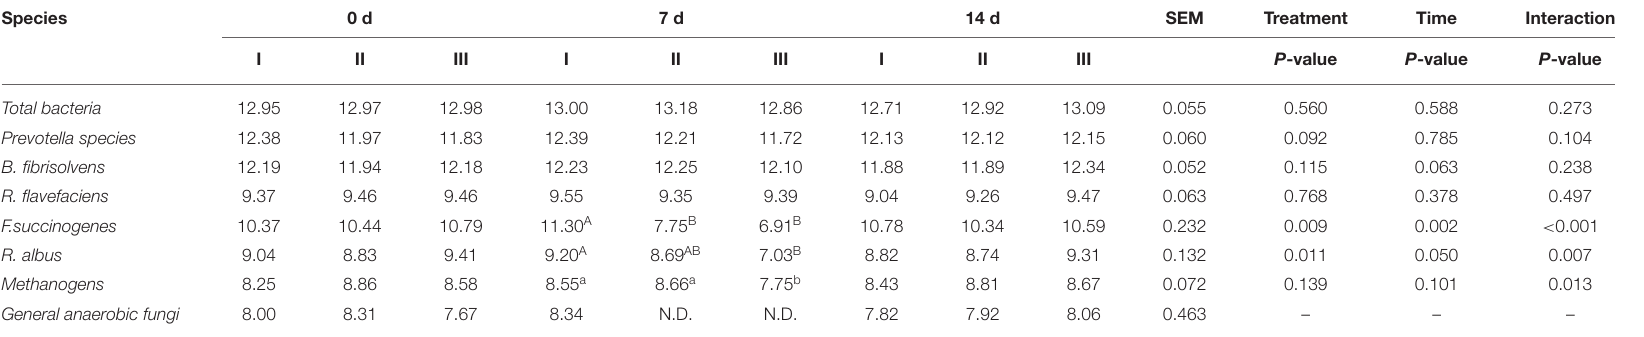
TABLE 3 | Log copies of a target microorganism in rumen fluid of lambs (Multiple comparisons between time at a specific treatment). Species